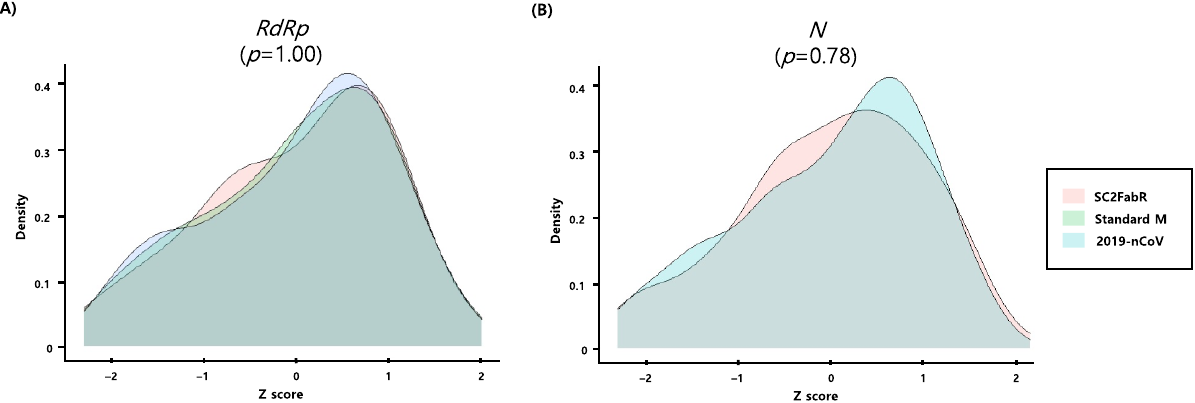
Figure 3. Densities of transformed Ct values obtained from SARS-CoV-2 data following within-assay normalization. Solid lines correspond to the SC2FabR, Standard M, and 2019-nCoV assays. RdRp gene, gene encoding the RNA-dependent RNA polymerase of SARS-CoV-2 ( A ); N , gene encoding the nucleocapsid protein of SARS-CoV-2 ( B ).